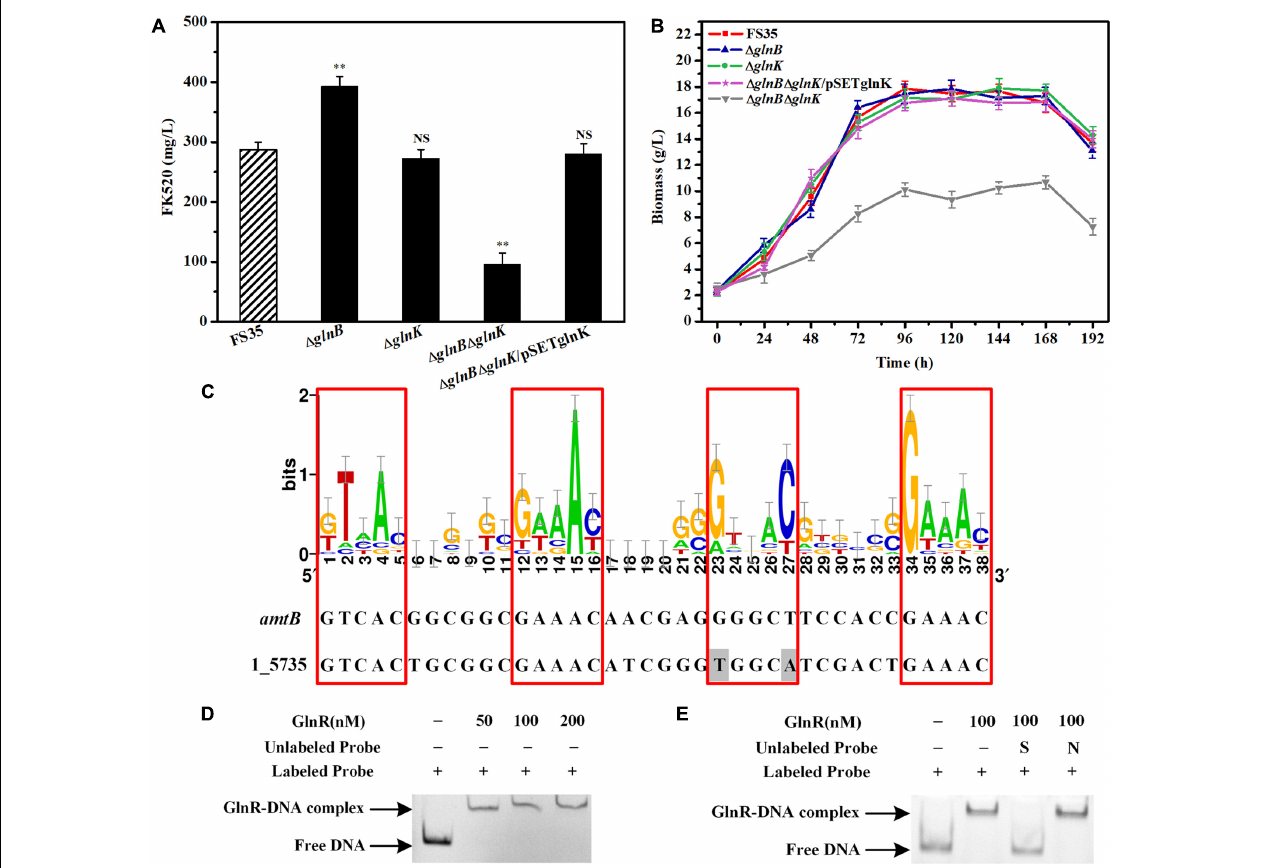
FIGURE 5 | Effects of the PII proteins on the FK520 yield and biomass accumulation, and the regulation of glnK gene expression by GlnR. (A) The changes of FK520 yield caused by the deletion of PII proteins or the complementation of GlnK protein. The FK520 yield of the parent strain FS35 was used as a reference for comparison. (B) Changes of biomass caused by the deletion of PII protein or the complementation of GlnK protein. The biomass of the parent strain FS35 was used as a reference for comparison. (C) The DNA binding sites of the regulator GlnR in the promoter region of the amtB-glnK-glnD operon in Streptomyces hygroscopicus var. ascomyceticus . The sequence logo was created using WebLogo (http://weblogo.berkeley.edu/logo.cgi) based on the known DNA binding sites of GlnR in Streptomyces coelicolor . The binding site of GlnR in the promoter region of amtB from S. coelicolor was used as a reference for comparison. The amino acid sequences of the promoter region of 1_5735 and the GlnR regulator from S. hygroscopicus var. ascomyceticus have been uploaded to the GeneBank database (1_5735: MW936366, GlnR: MW936365). (D) EMSA for determining the formation of a protein-DNA complex between the GlnR regulator and the promoter sequence of the amtB-glnK-glnD operon. (E) Assessment of the specificity of the interaction between the GlnR regulator and the promoter of amtB-glnK-glnD operon. All blots on the gel map indicated the free DNA or GlnR-DNA complex fractionated by EMSA. S represents the specific unlabeled probe used for competitive binding to the regulator GlnR. N represents the non-specific unlabeled probe. The (cid:49) glnB represents the glnB deletion strain based on the parent strain FS35. The (cid:49) glnK represents the glnK deletion strain based on the parent strain FS35. The (cid:49) glnB (cid:49) glnK represents the glnB - glnK double deletion strain based on the parent strain FS35. The (cid:49) glnB (cid:49) glnK /pSETglnK represents the glnK complementation strain based on the glnB - glnK double deletion strain (cid:49) glnB (cid:49) glnK . All data represent the mean values of five independent technical replicates, and the error bars represent the standard deviations. Asterisks indicate significant differences between